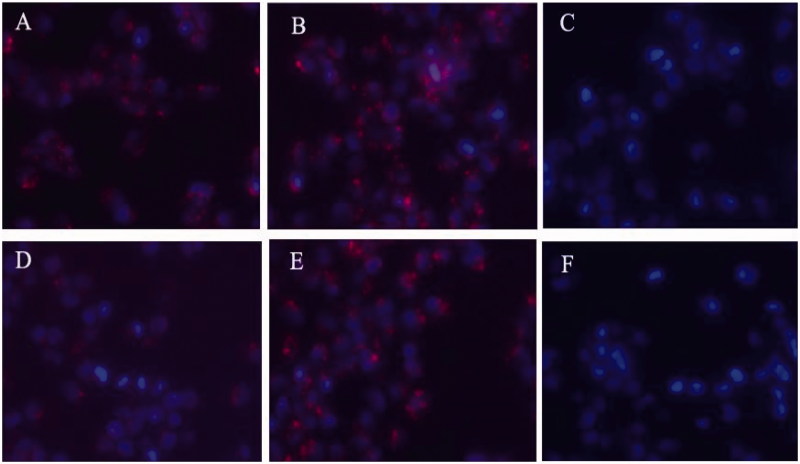
Uptake of Rhodamine-L-FP21, and Rhodamine-D-FP21 by HO8910 cells and 293T cell. Images A,B are fluorescence images of uptake of Rhodamine-L-FP21, and Rhodamine-D-FP21 by HO8910 cells after 4-h incubation, respectively. Images D,E are fluorescence images of uptake of Rhodamine-L-FP21, and Rhodamine-D-FP21 by HO8910 cells after 12-h incubation, respectively. Images C,F are fluorescence images of uptake of Rhodamine-L-FP21 and Rhodamine-D-FP21 by 293T cells after 4-h incubation, respectively: red represents red fluorescence protein expressed by Rhodamine; DAPI represents cell nuclei stained with DAPI. Original magnification, 200×.